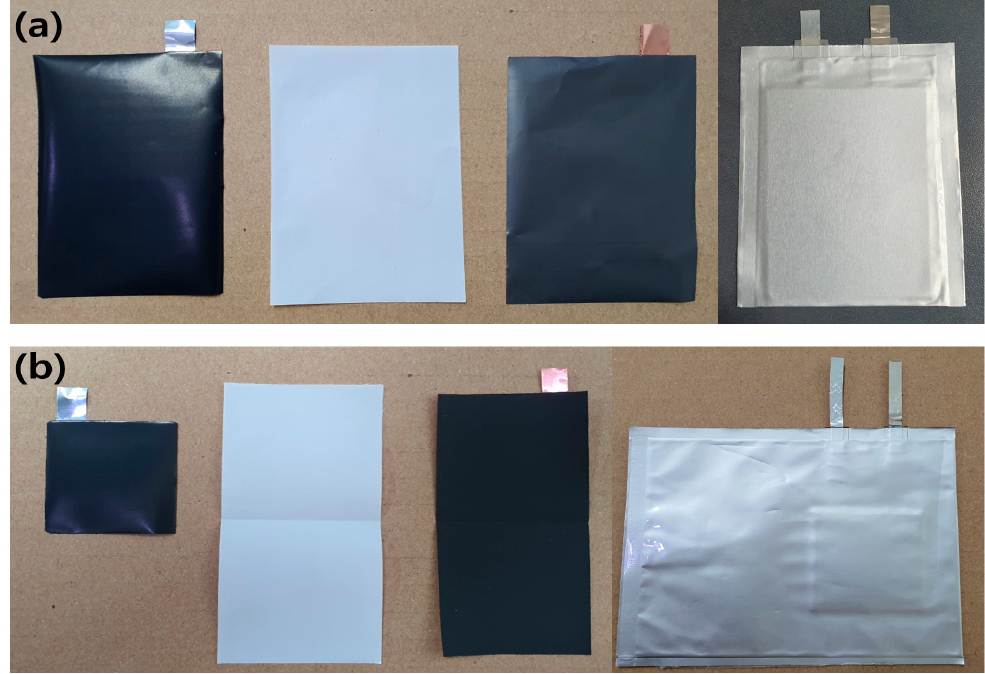
Figure 1. Photographs of the cathode, separator, and anode components (left) and the assembled cells (right) for the ( a ) PFCs and ( b ) SLPCs.